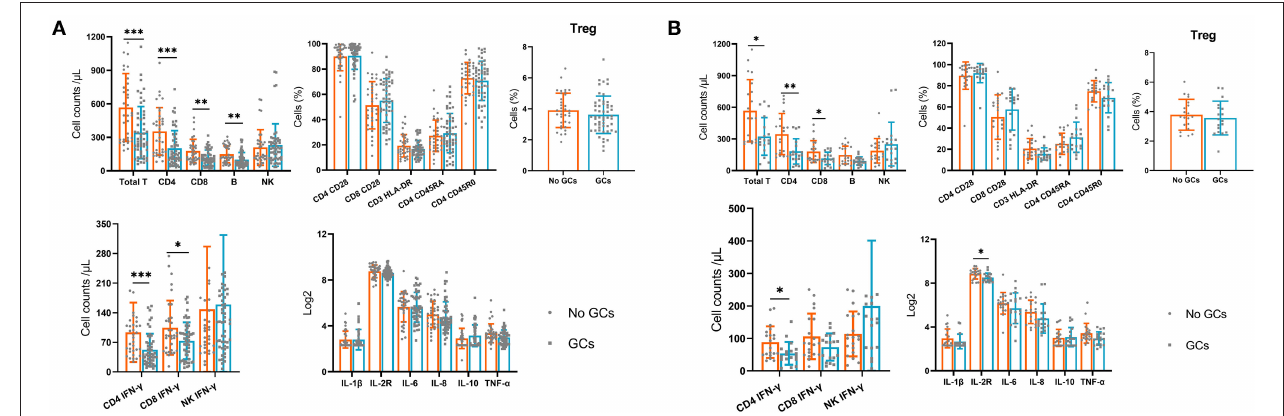
FIGURE 2 | The lymphocyte subsets, lymphocyte phenotypes, lymphocyte functions and inflammatory cytokines in the GCs group and no GCs group at 1 day postoperatively. (A) Before propensity score matching. (B) After propensity score matching. * p < 0.05, ** p < 0.01, *** p < 0.001.